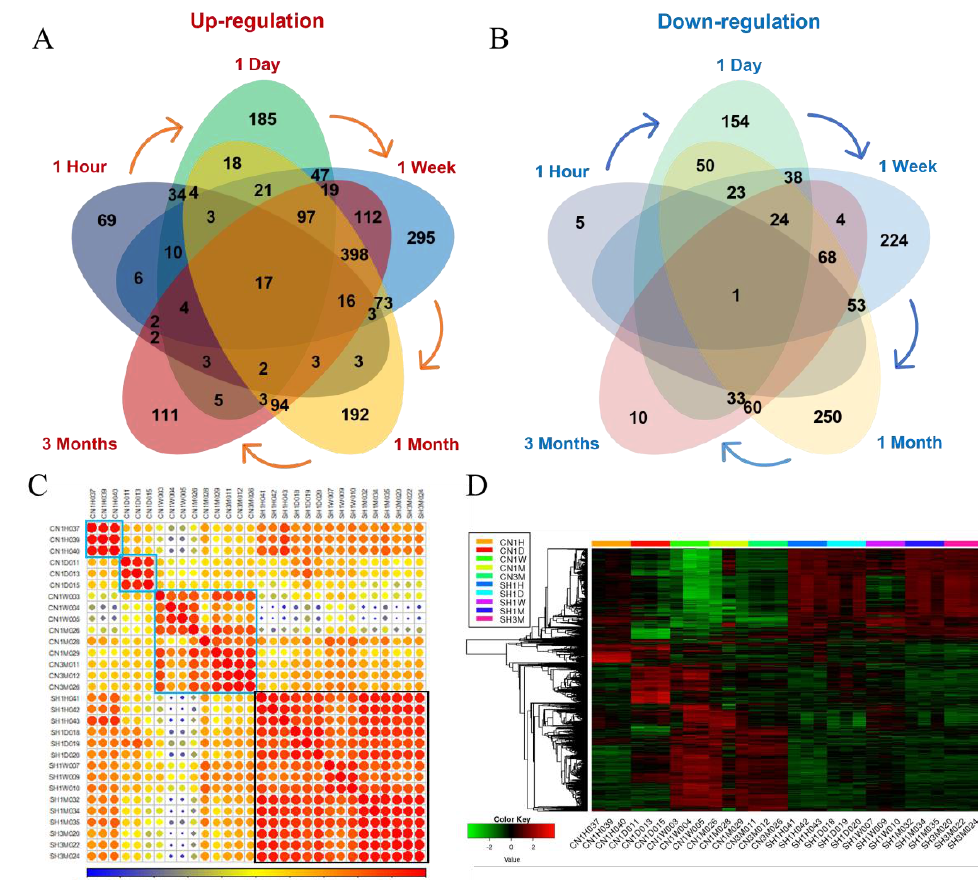
Figure 5. Summary of DEG analysis and significant aspects of transcriptional transition at five time points after SCI. ( A , B ) the number of up- ( A ) and downregulated ( B ) genes identified in the five comparison sets (contusion vs. sham cases at five time points). Overlapping areas in the Venn diagram represent genes common to every comparison group. ( C ) Pairwise Pearson correlation coefficients (PCCs) were calculated to investigate the correlation based on 2841 DEGs. A correlation matrix is gradually represented from 0.61 negative correlation (blue) to one positive correlation (red). ( D ) Hierarchical clustering heatmap for a total of 2481 DEGs identified at all time periods are represented. A histogram in the color key shows the number of expression values within each color bar. Abbreviation: CN = contusion model, SH = sham-treated